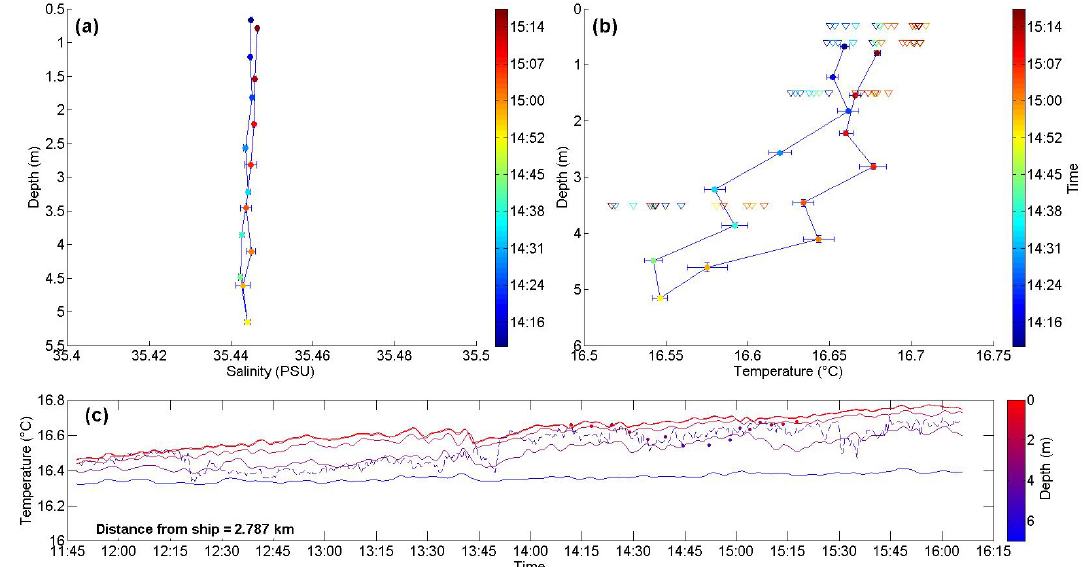
Figure 6. Salinity and temperature in the central Celtic Sea on 30 July 2015. NSOP profiles of salinity (a) and temperature (b) were derived using depth bins as described in Sect. 2.6. Data points are coloured by sampling time. Vertical and horizontal error bars show 2 standard errors of the mean in each depth bin. Coloured triangles in (b) are time-averaged temperature for four depths (0.3, 0.6, 1.5 and 3.5m) at the nearby central Celtic Sea temperature mooring (49.403 ◦ N, − 8.606 ◦ E). (c) Time series of temperature at the mooring. Time series of temperature at depths (0.3, 0.6, 1.5 and 3.5m) are solid lines whereas the dashed line is the underway temperature at 5.5m from RRS Discovery (located 2.8km from the mooring). The mooring and underway temperatures are coloured according to their sample depth, where red is the air–sea interface. The circles are binned temperature data from NSOP, which have also been coloured to reflect the depth of